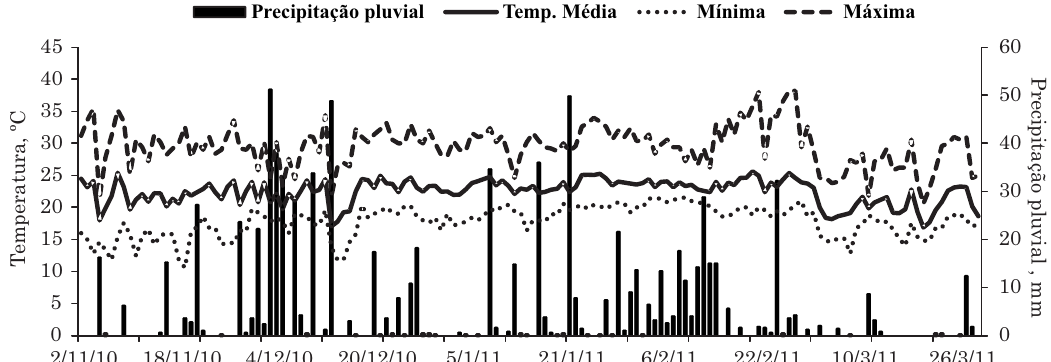
Figura 1. Precipitação pluvial, temperaturas máxima, mínima e média durante o período de desenvolvimento da cultura no